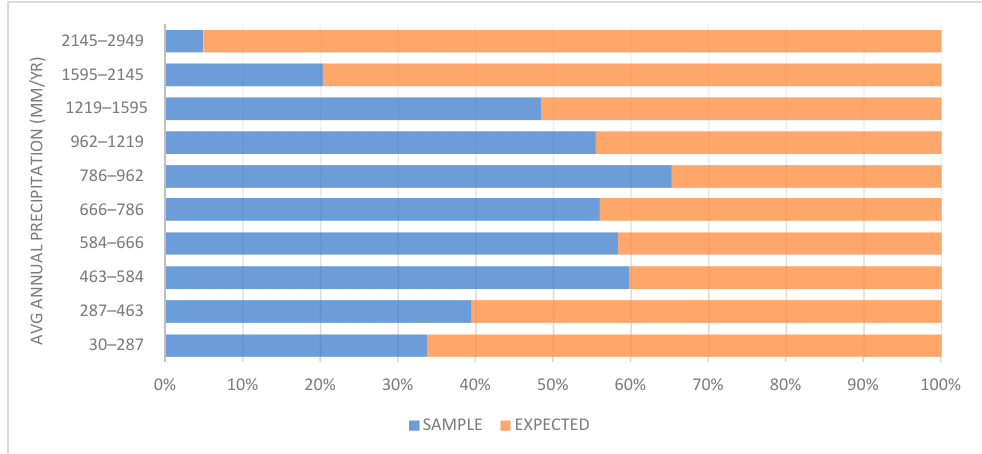
Figure 11. Percentage of Observed (~Sample) vs. Expected Counts for Average Annual Precipitation Variable.